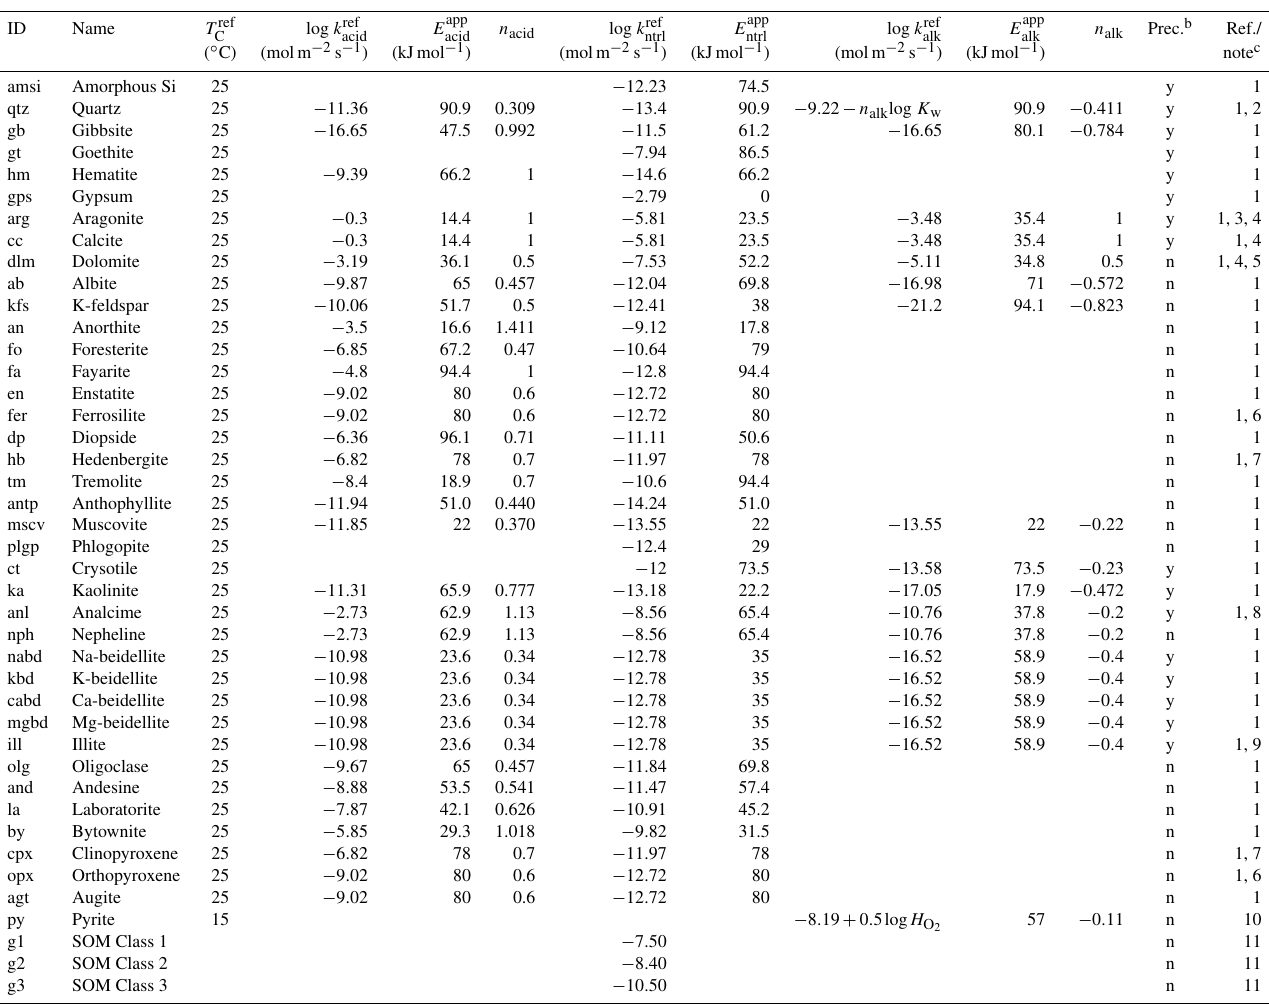
Table 2. Dissolution/precipitation kinetic data of solid species a